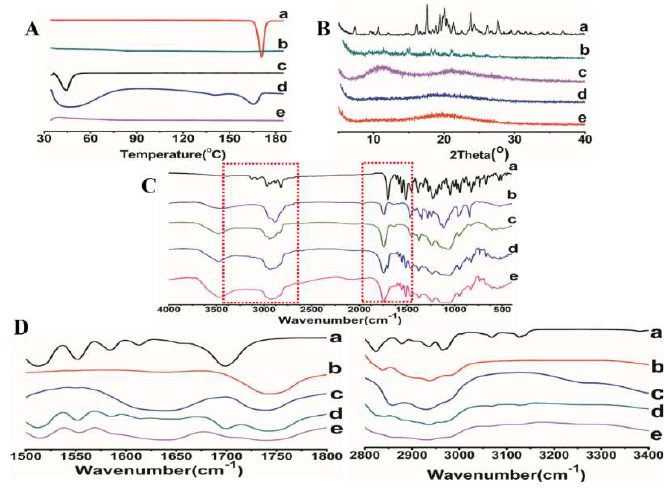
Figure 5. DSC ( A ), XRD ( B ), and FTIR spectra ( C , D ) of ( a ) ITZ powder, ( b ) HPMC AS, ( c ) TPGS, ( d ) the physical mixture of ITZ-HPMCAS-TPGS, ( e ) ITZ-HPMC AS-TPGS ASD formulation.